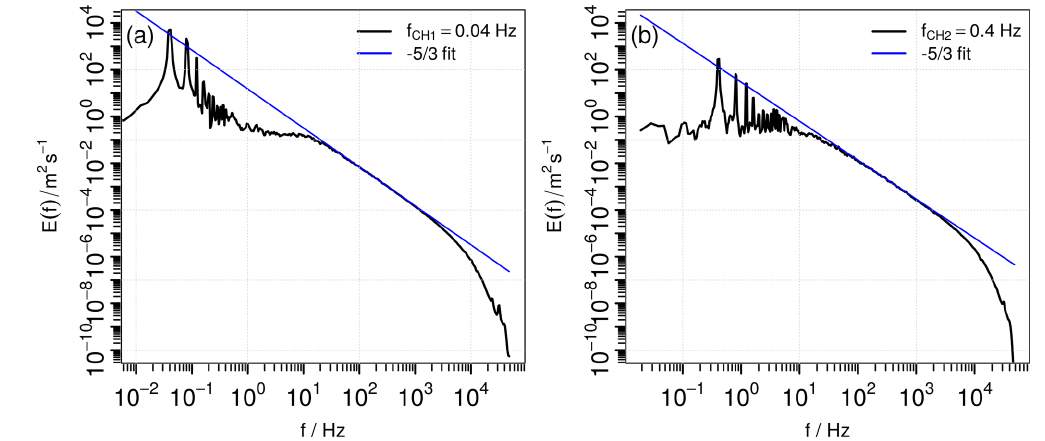
Figure 4. Energy spectral density of the measured time series at the centerline 5.425 w CH from the inlet for the chopper frequencies